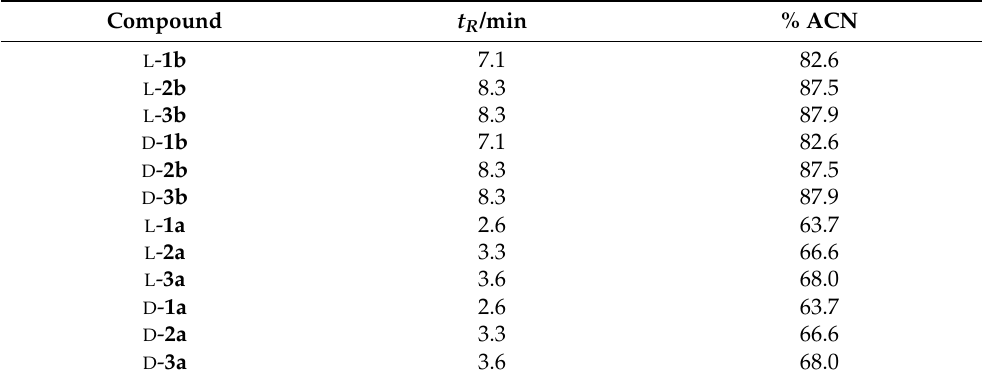
Table 4. List of the peptides used in the study. The abbreviation, retention time ( t R ), and percentage of acetonitrile (% ACN) at elution are